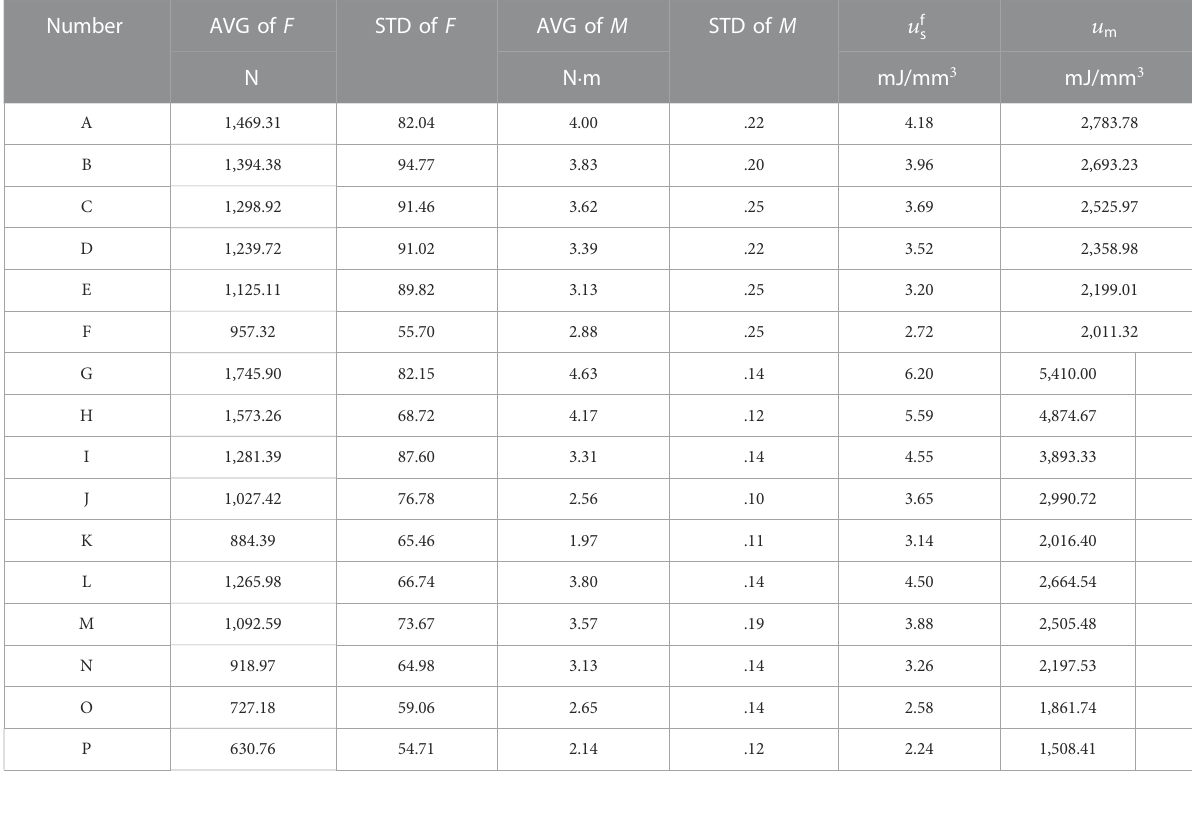
TABLE 5 Statistical parameters.